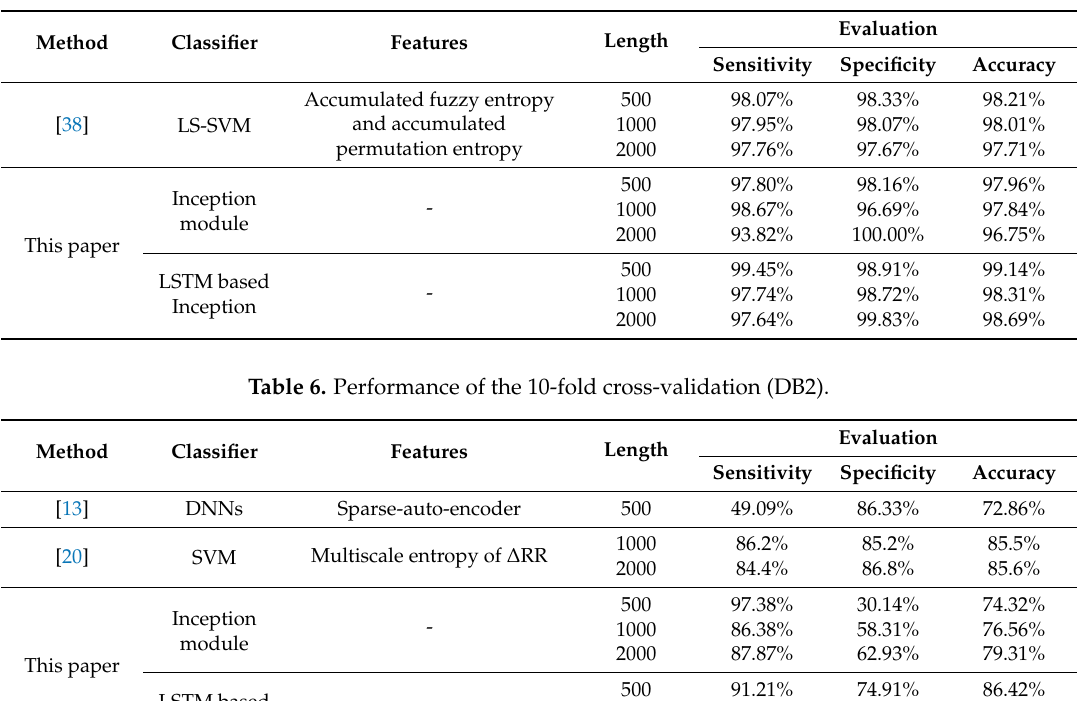
Table 5. Performance of the 10-fold cross-validation (DB1).